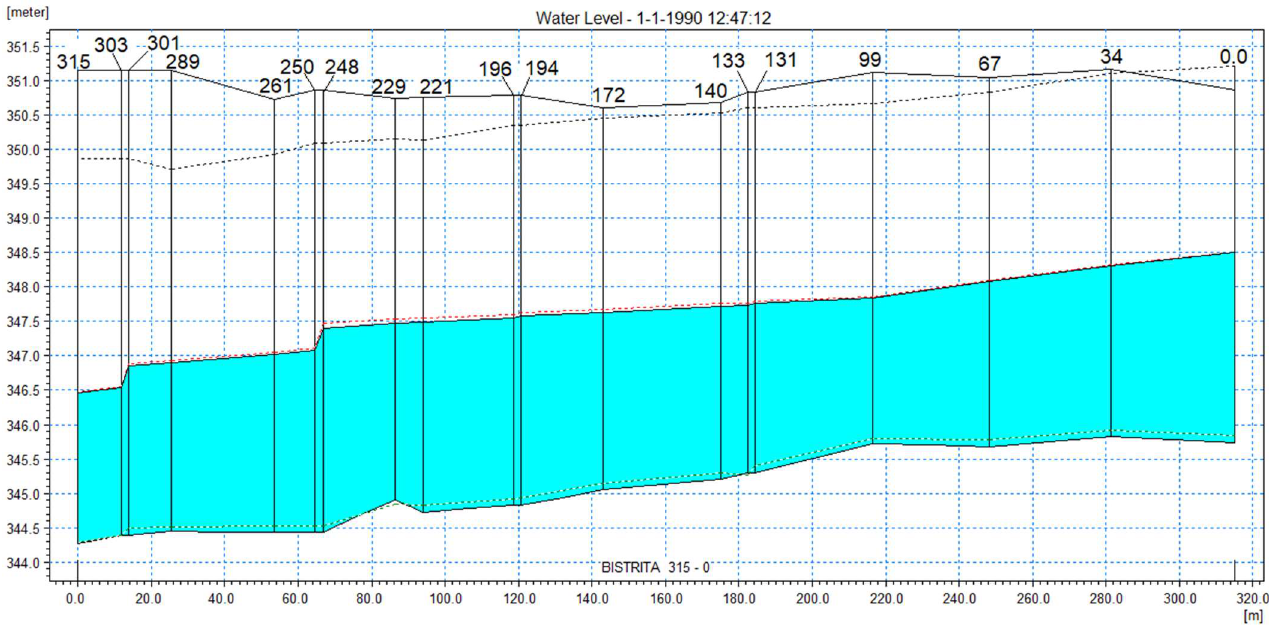
Figure 16. Water level for flow Q = 128 m 3 /s, representing an extreme flood flow recorded in 2020. For the proposed case with the lowering of the crest of the existing weir and the construction of three new weirs of low height downstream of it.